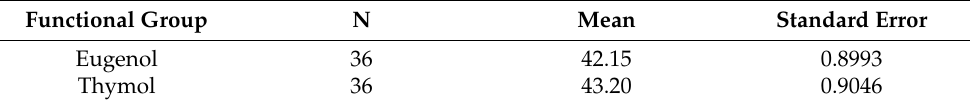
Table 6. Group statistics (FDI) (%) between eugenol and thymol derivatives. Functional Group N Mean Standard Error Eugenol 36 42.15 0.8993 Thymol 36 43.20